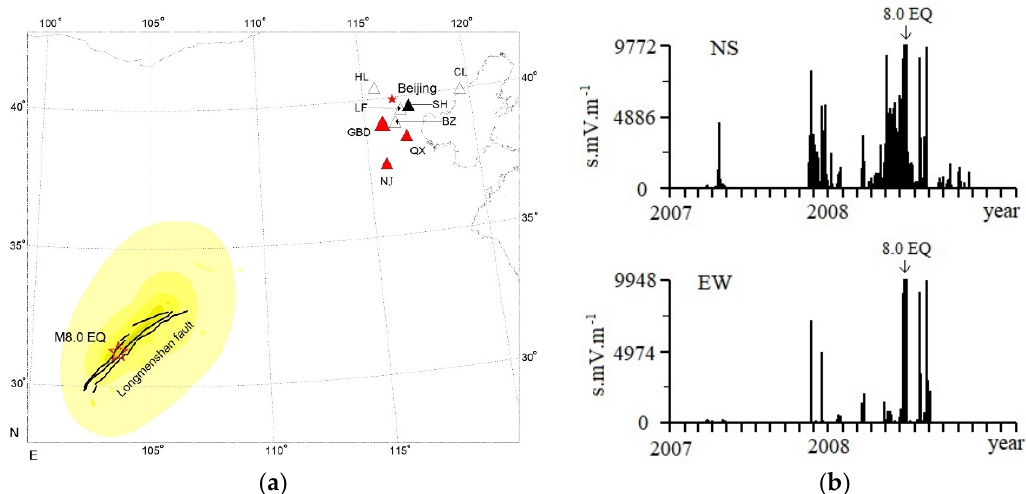
Figure 2. ( a ) Locations of the Wenchuan earthquake (EQ) epicenter and ultra low frequency (ULF) EM observing stations. Red solid triangles are stations recording ULF electrical emissions during the Wenchuan EQ; the black solid triangle shows the Sanhe (SH) station which was running when the event occurred but recorded no anomaly; empty black triangles show the stations out of order during the Wenchuan event. The Wenchuan main shock is labeled by a red empty star. The red solid star denotes Beijing. ( b ) Timeline of daily total cumulative amplitude (black bar) of electromagnetic information recorded at the Gaobeidian (GBD) station during 2007–2008.